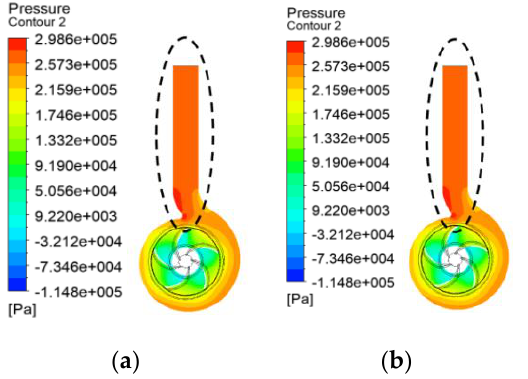
Figure 11. Velocity vector of flow region at 1000 rpm. ( a ) Original model; ( b ) rounded model.